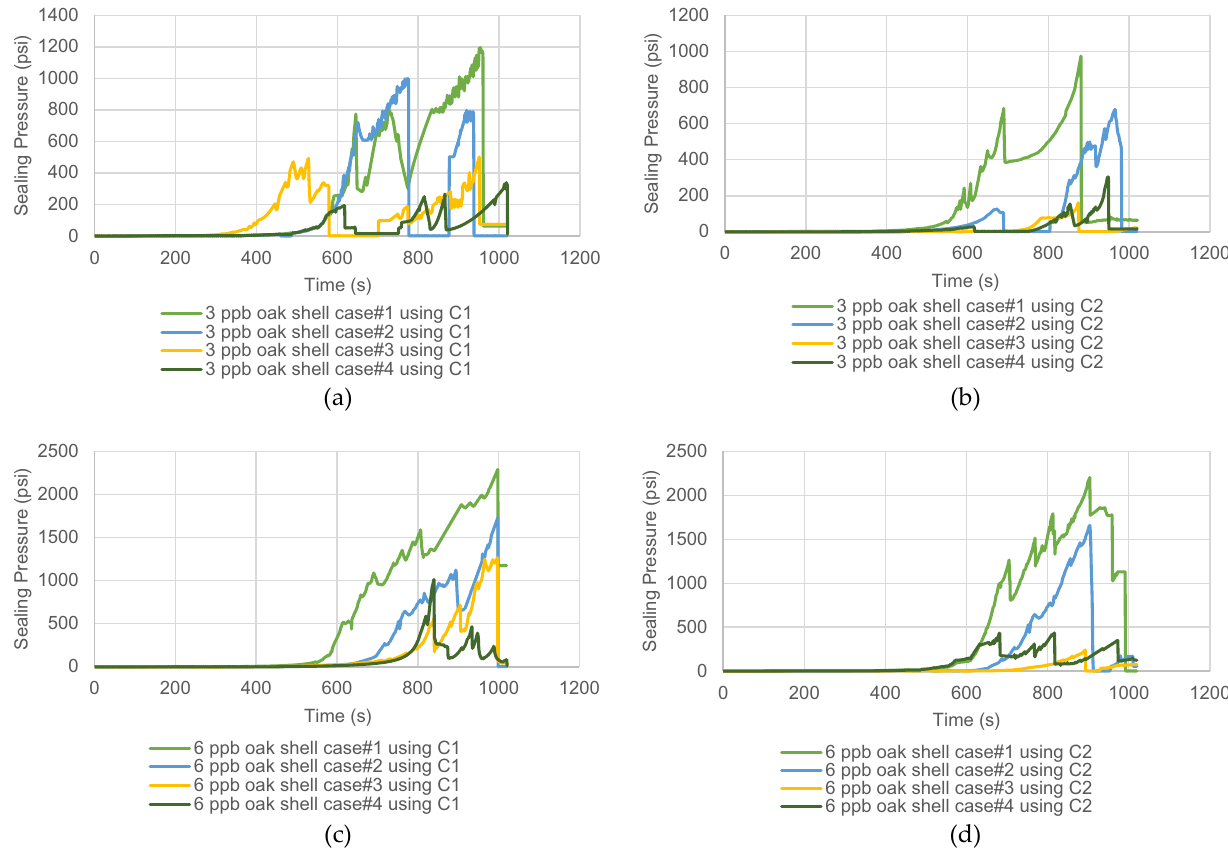
Fig. 27 HPA Pressure versus Time plot for 3 & 6 ppb Oak shell showing maximum sealing pressure at different cases using C1 and C2